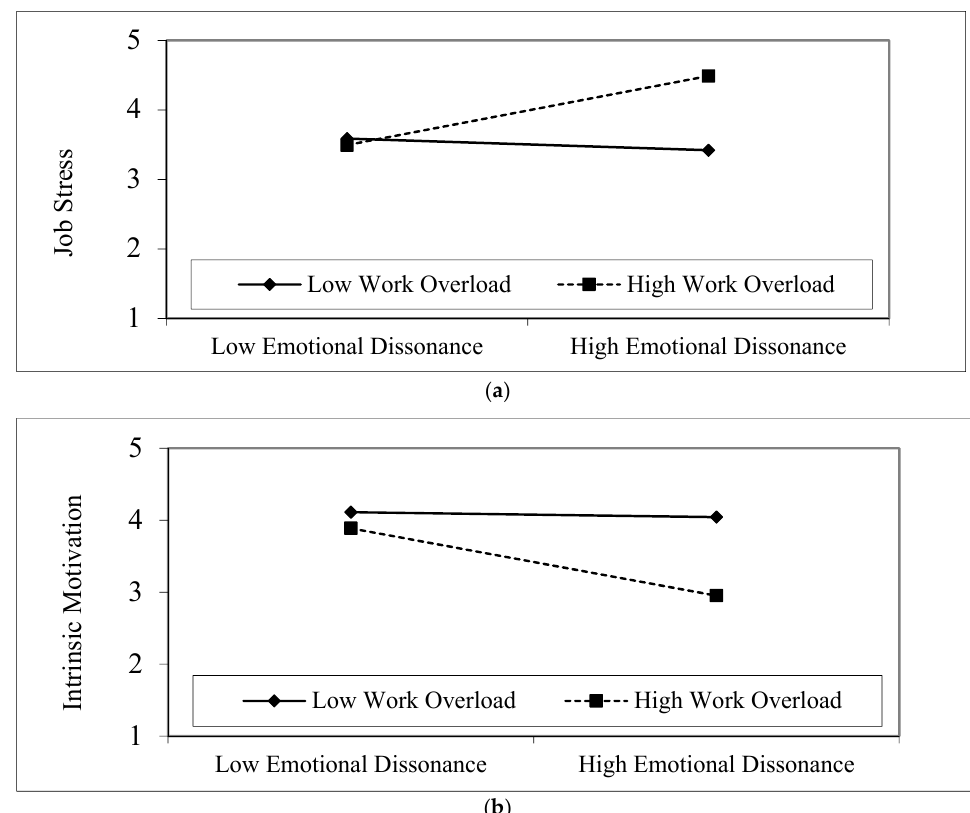
Figure 2. ( a ) The moderating effects of work overload on intrinsic motivation. ( b ) The moderating effects of work overload on intrinsic motivation.